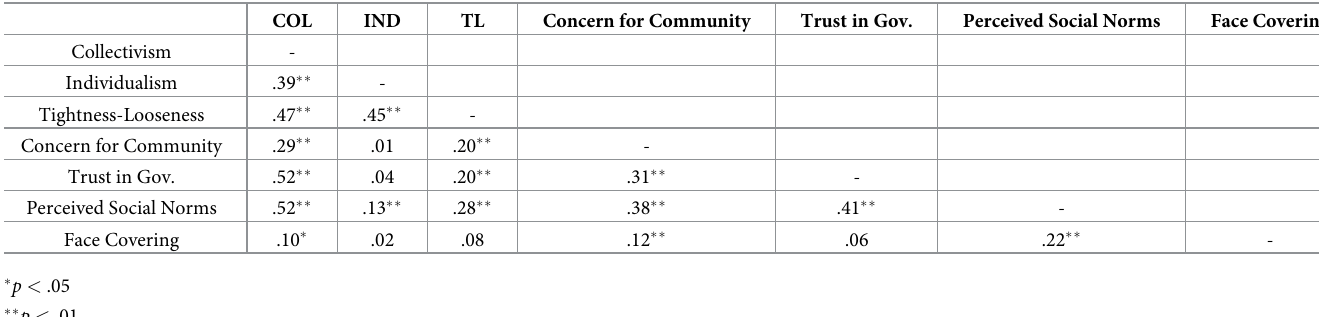
Table 4. Zero-order correlations between key variables related to face covering (FC). COL